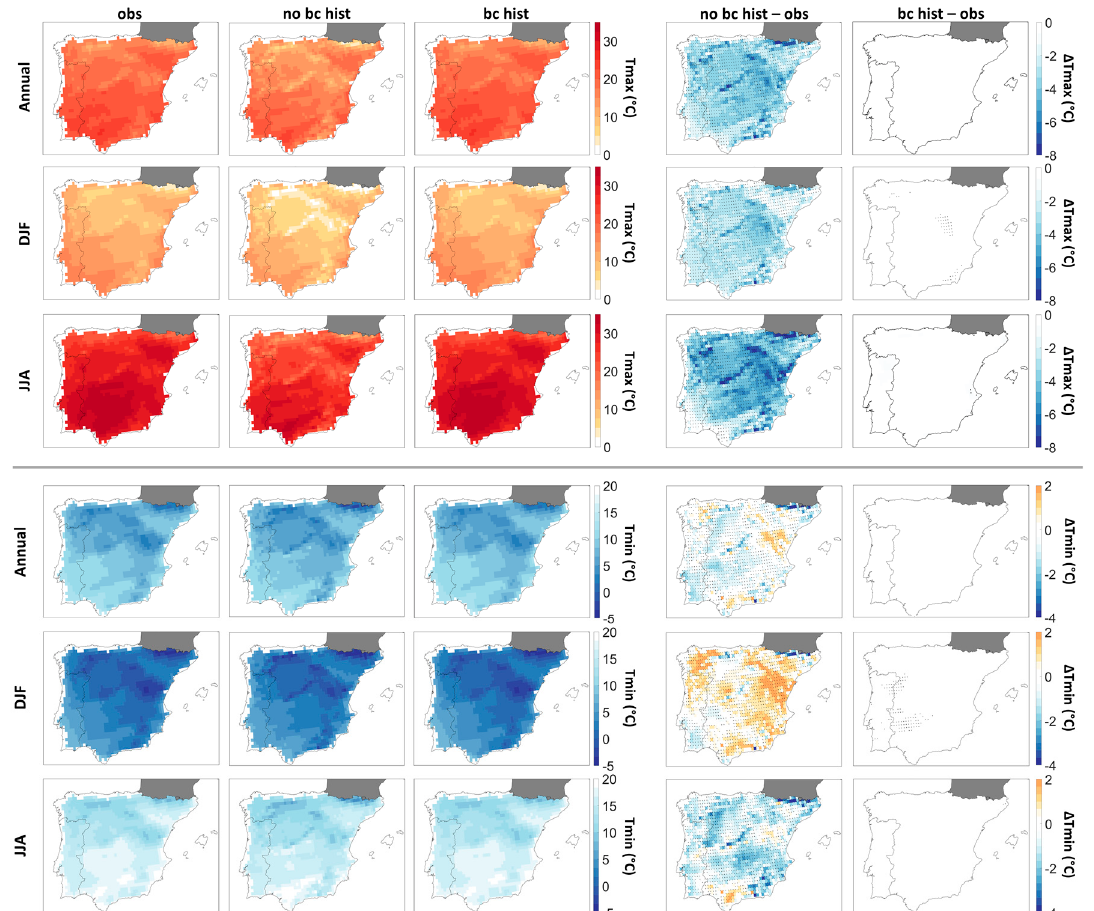
Figure 3. Mean daily maximum and minimum temperature (Tmax and Tmin, °C) [first row, annual; second row, winter (DJF); third row, summer (JJA)] of the observations (obs) and the simulations with no and with bias correction (no bc hist and bc hist, respectively) for the historical period. Differences between the mean spatial distribution with no and with bias correction and the observations (no bc hist–obs and bc hist–obs, respectively). Statistically significant differences (Student’s t -test) at 5% significance level are represented by black dots.